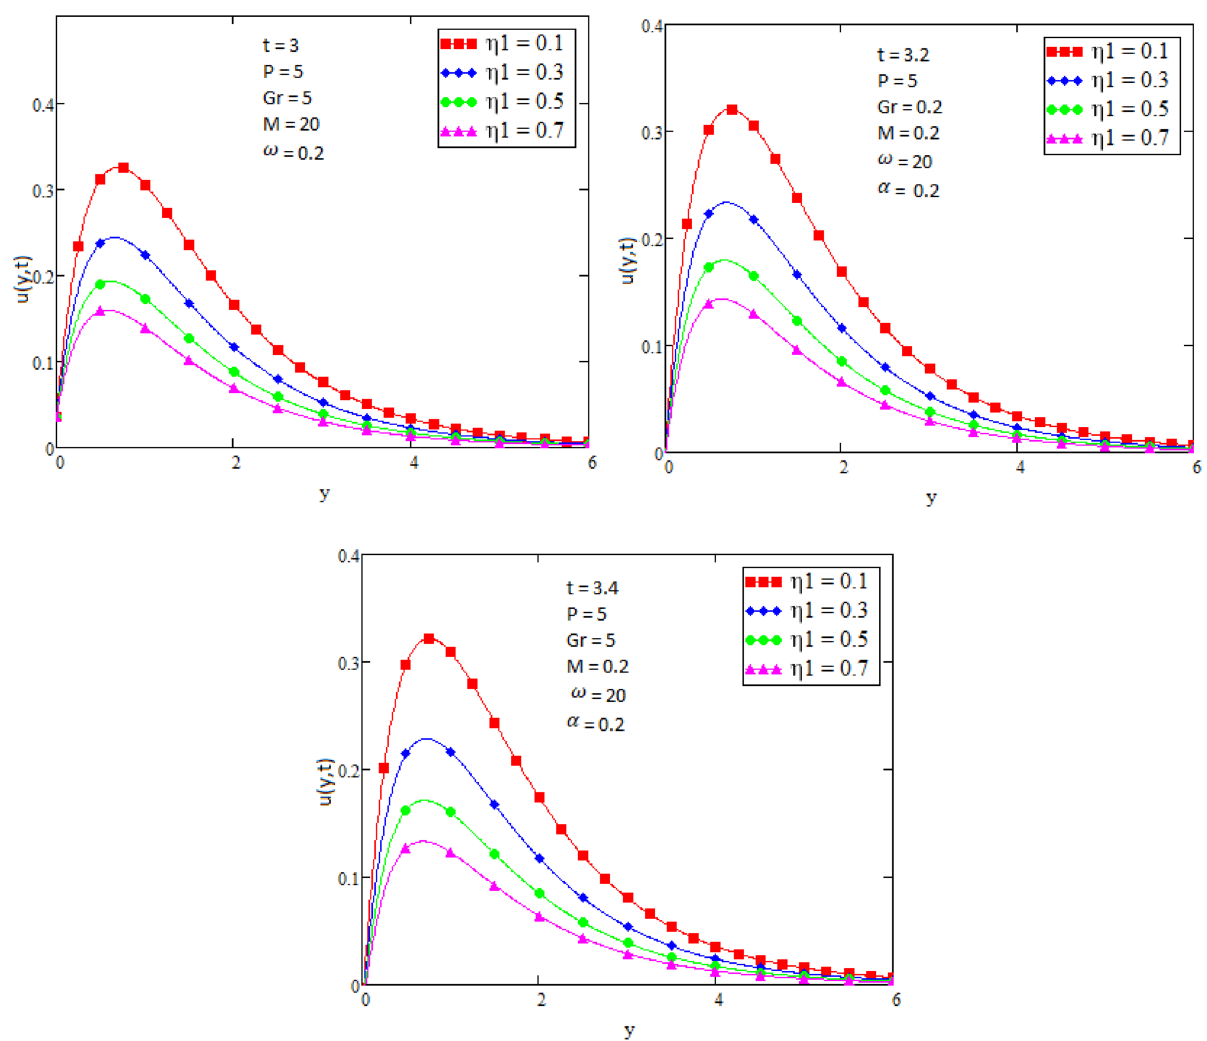
Figure 6. Velocity profile for different values of Eta η 1